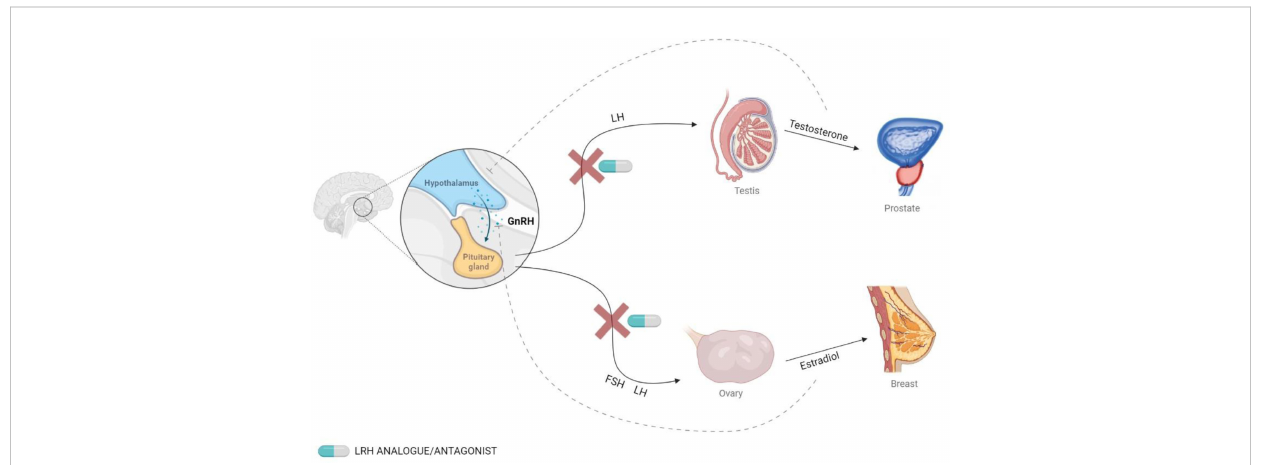
FIGURE 1 Secretion of GnRH and the effects on hormonal levels. GnRH is secreted by the hypothalamus and binds to its receptor in the pituitary gland, which stimulates the release offollicle-stimulating hormone (FSH) and luteinizing hormone (LH). This effect can be blocked using GnRH